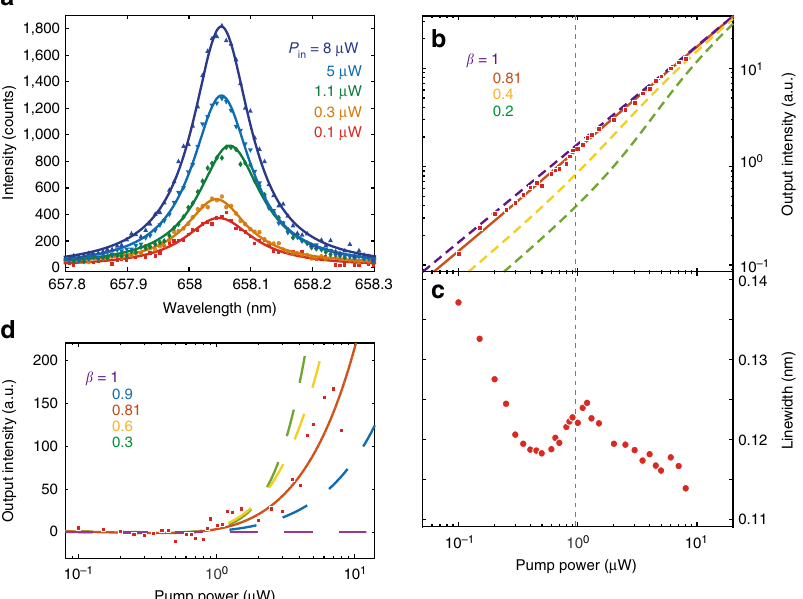
Fig. 3 Observation and characterization of nanoplatelet lasing. a Emission spectra from nanoplatelets coupled to the cavity under different pump powers. Symbols indicate the measured data, and the lines are Lorentzian fi ts. Keys are pump powers for corresponding spectra in the same colours. b Output intensity, determined from the Lorentzian fi ts, as a function of the total pump power. Red squares are measured data, and the solid curve is a fi t to the laser rate equation, corresponding to a spontaneous emission coupling ef fi ciency β = 0.81. Dashed curves are calculation results for other values of β . c Cavity linewidth as a function of pump power. The vertical dashed line ( orange ) in both ( b ) and ( c ) indicates the lasing threshold obtained from the fi t. d Output intensity after subtracting a linear fi t to the data points below threshold. The solid curve is the fi t to the laser rate equation, and dashed curves are calculated for other values of